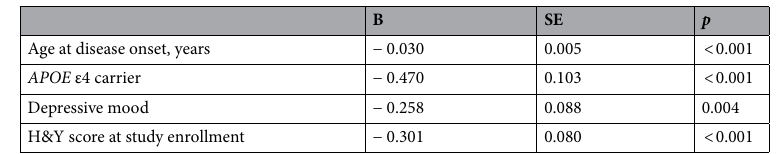
B SE p Age at disease onset, years − 0.258 − 0.301 < Table 2. Stepwise linear regression showing factors significantly associated with the mean annual change in MMSE in patients with Parkinson’s disease. H&Y Hoehn and Yahr; MMSE mini-mental state exam.